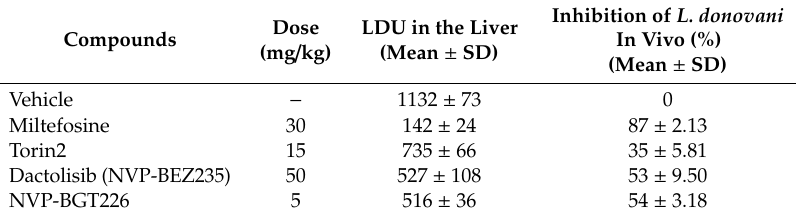
Table 2. E ffi cacy of tested compounds in L. donovani —infected BALB / c mice. Inhibition of L. donovani Dose LDU in the Liver Compounds In Vivo (%) (mg / kg) (Mean ± SD)